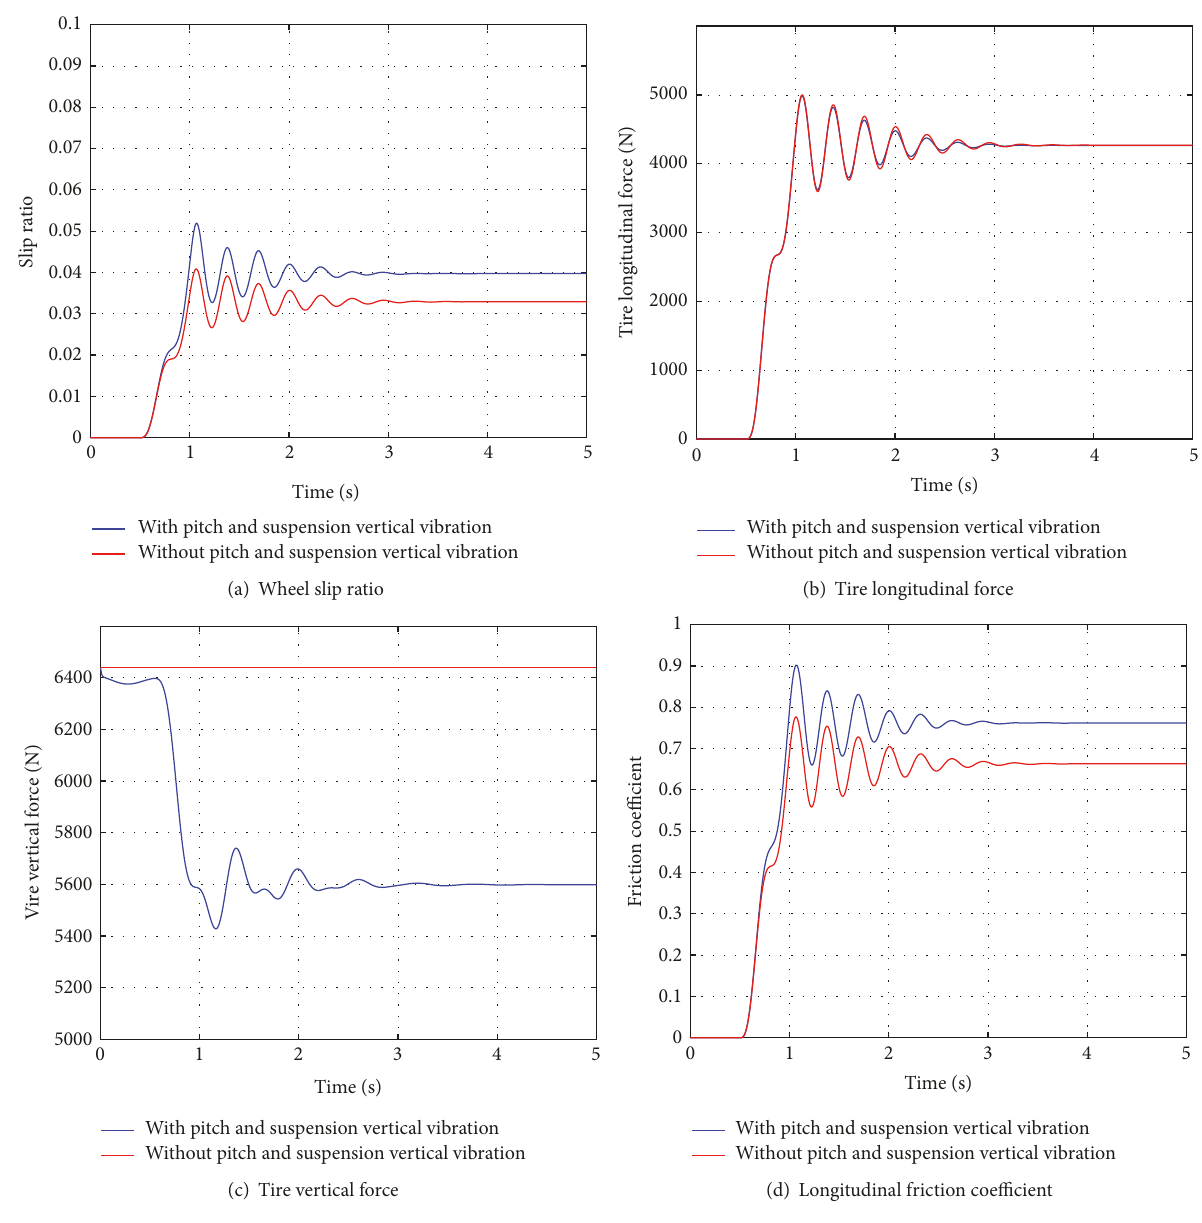
Figure 16: States of vehicle model with/without considering suspension vertical